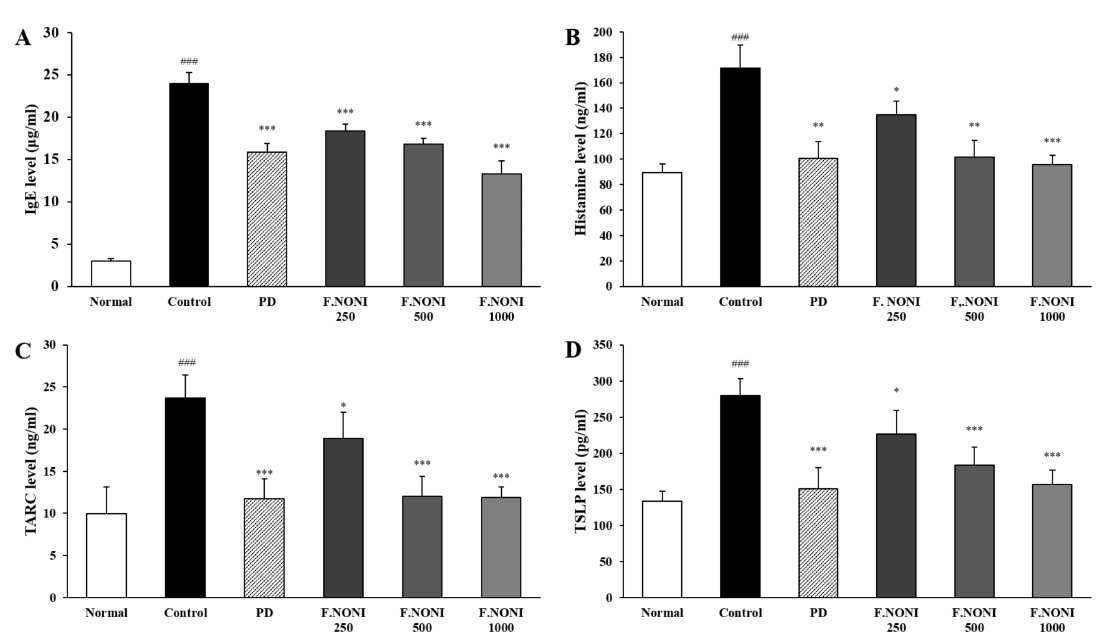
Figure 4. E ff ect of F.NONI on levels of AD-related cytokines and IgE in the serum of AD-induced NC / Nga mice. ( A ) Levels of IgE in serum; ( B ) levels of histamine in serum; ( C ) levels of TARC in serum; ( D ) levels of TSLP in serum. The sera of NC / Nga mice were collected on the last day of the experiment and measured using ELISA. The results were presented as mean ± SEM ( n = 6). ### p < 0.001 vs. normal, * p < 0.05, ** p < 0.01, *** p < 0.001 vs. control. Normal, untreated group; Control, atopic dermatitis induced by DNCB; PD, positive control (prednisolone 3 mg / kg) treated group; F.NONI (fermented